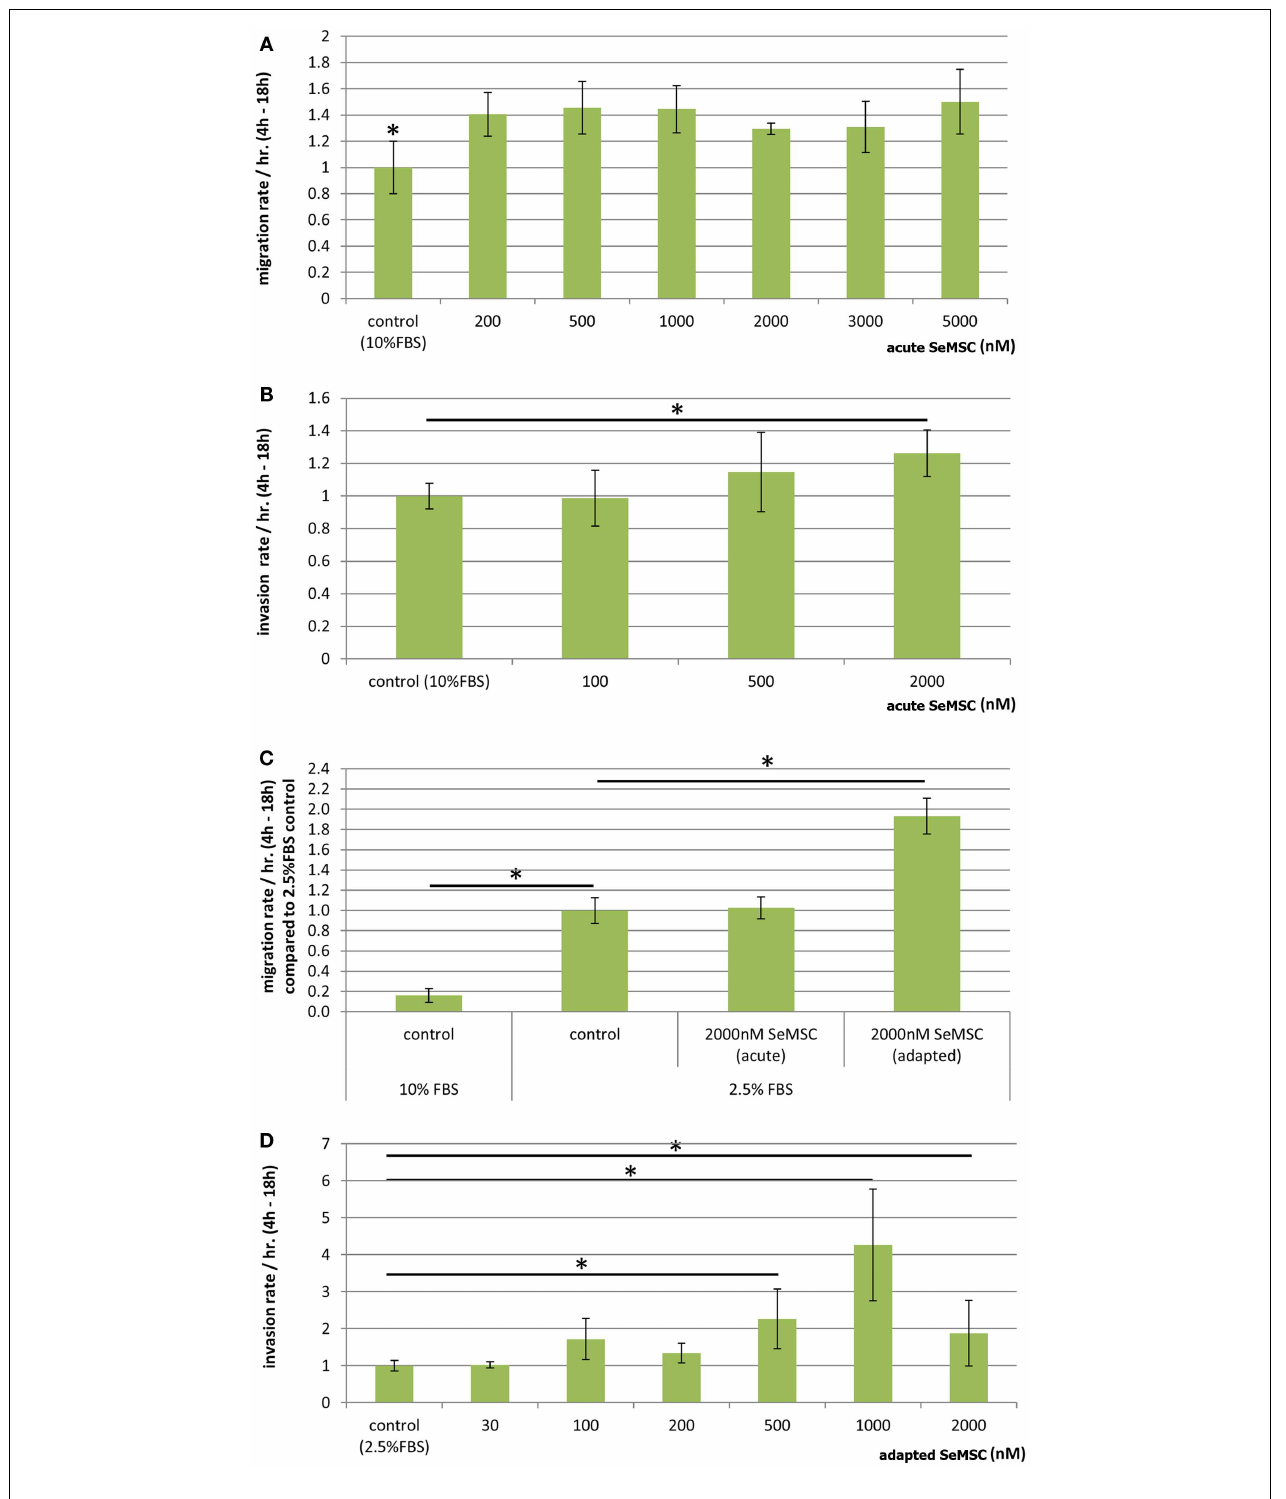
term adapted SeMSC treatment, (D) 44h dose-response study of long term/adapted SeMSC treatment on invasion of 2.5% serum cultured cells. Bar charts represent average migration or invasion rate per hour during the linear range of the 24h assay, three biological replicates, error bars ± SD. * p <